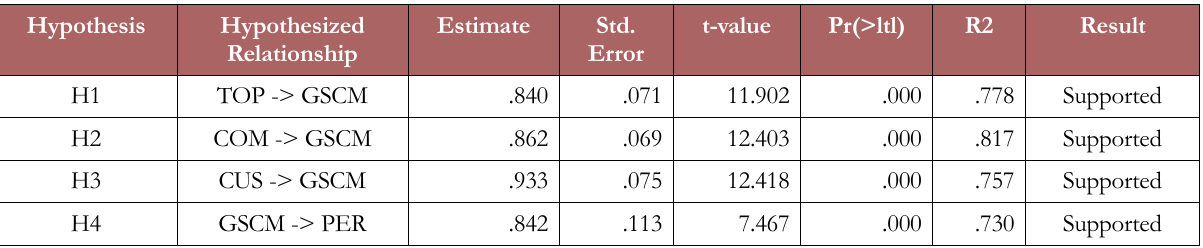
Table 2. Result of